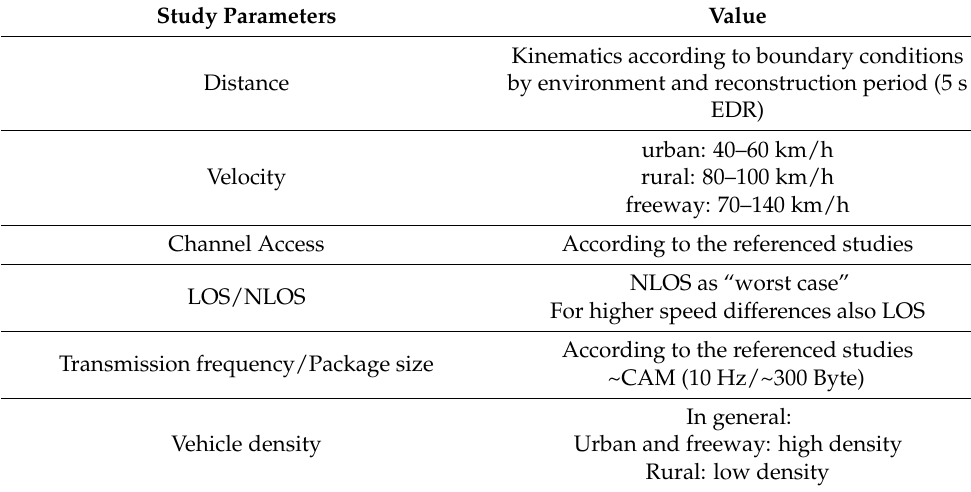
Table 1. Determination of the study